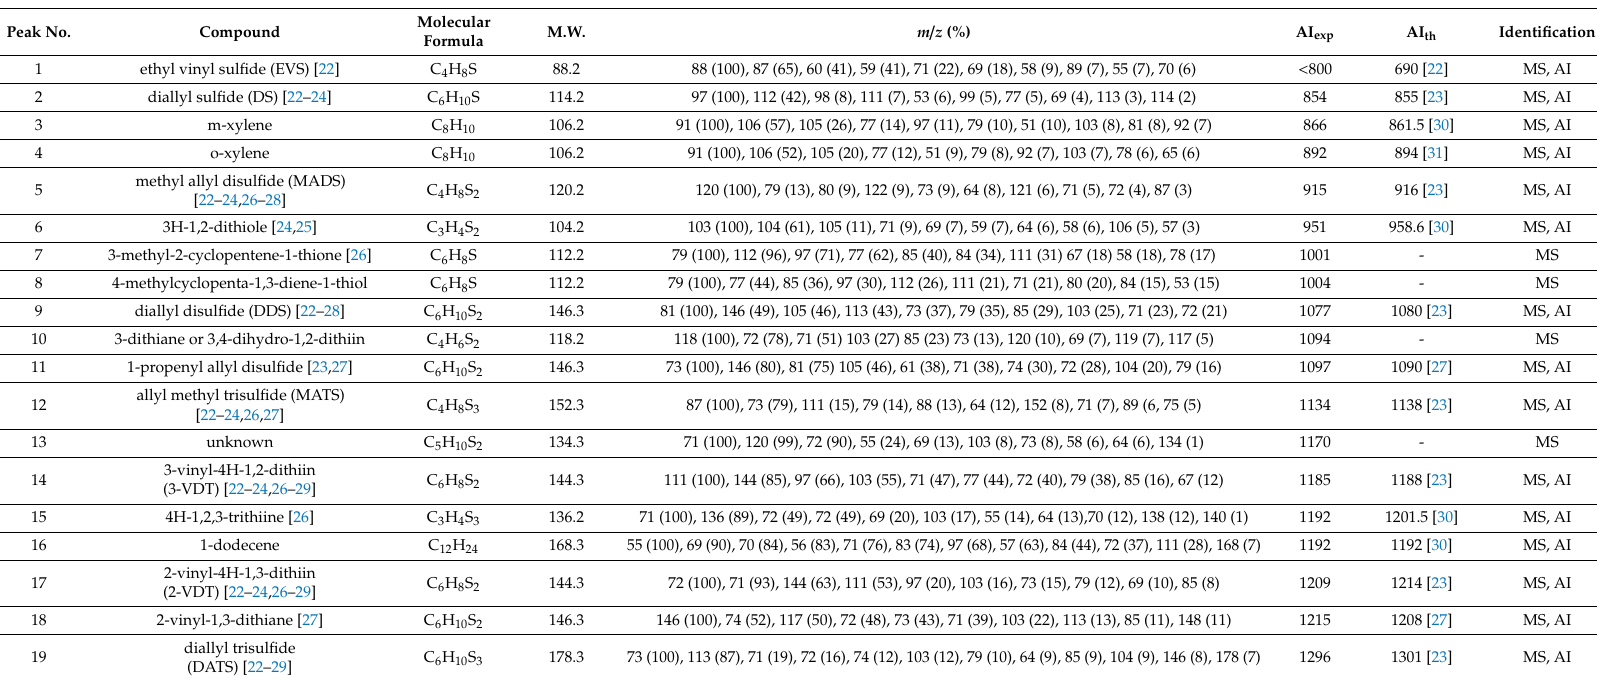
Table 3. Identity, mass spectral data, and retention indices (experimental AI exp and theoretical AI th on HP-5MS column) of volatile compounds in the garlic ethyl acetate extracts and previous references on their occurrence in